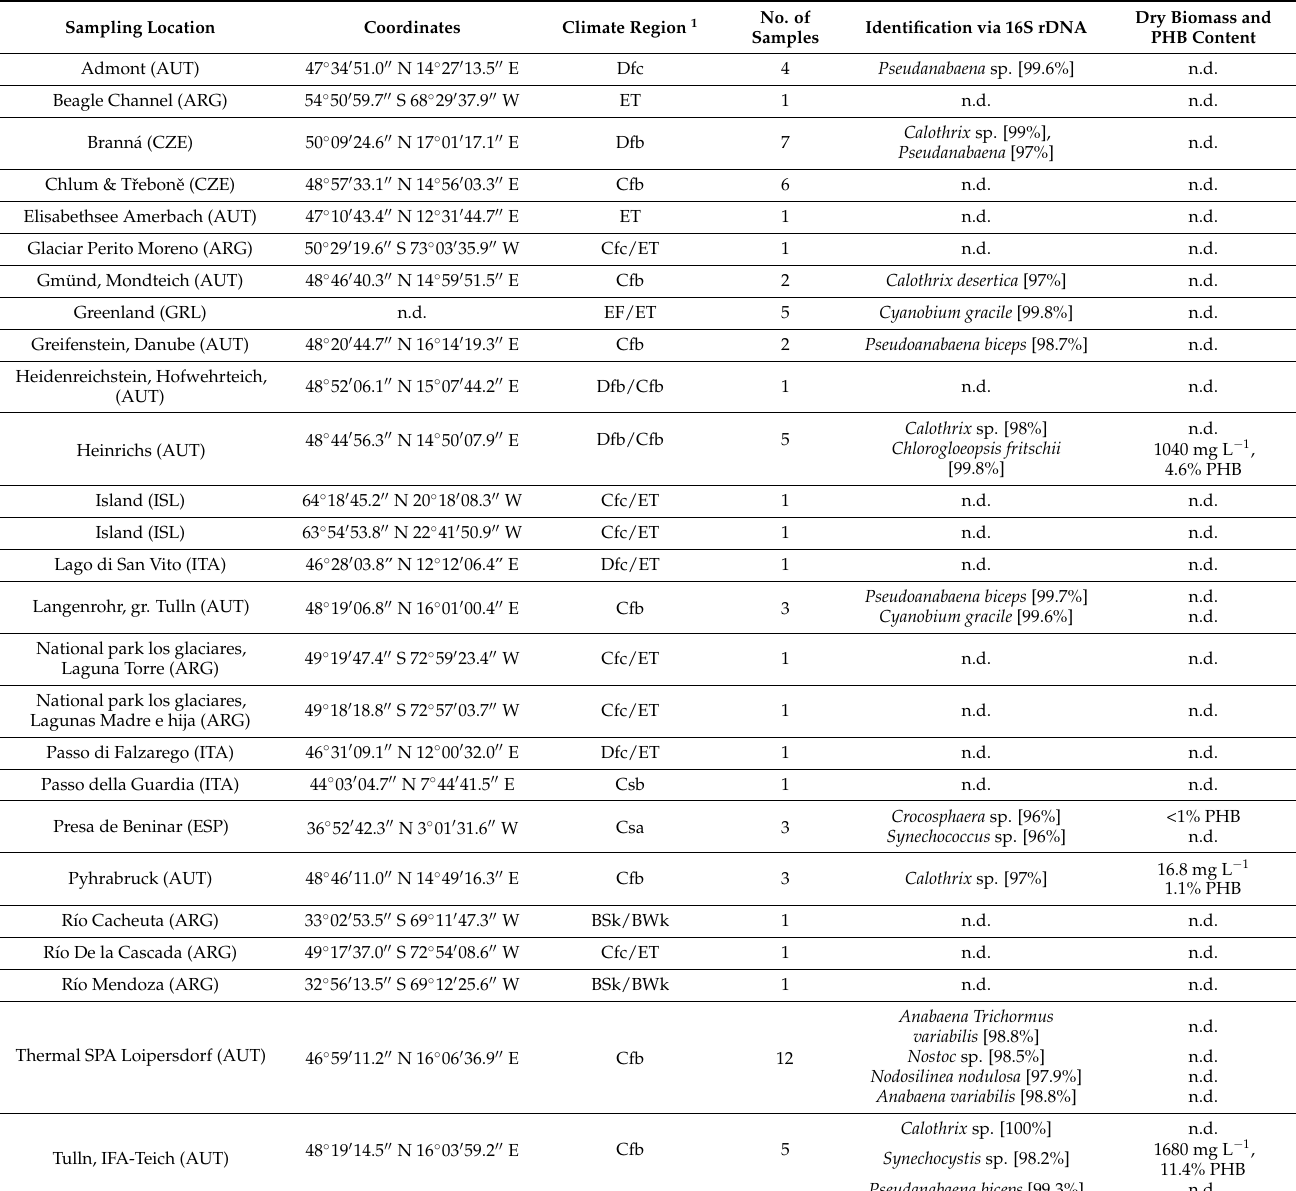
Table 1. Sampling locations with climate types and identified single-species strains. PHB production was tested by cultivation in a laboratory photobioreactor of ca. 5 L volume. Sequences are provided in Appendix